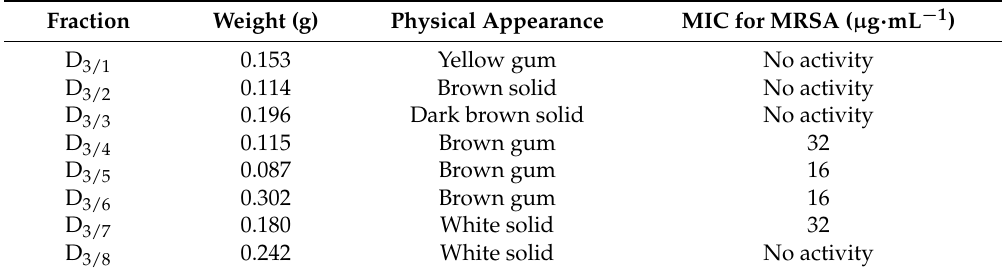
Table 2. ASDE subfractions of D 3 and their respective MICs against MRSA ATCC 43300.